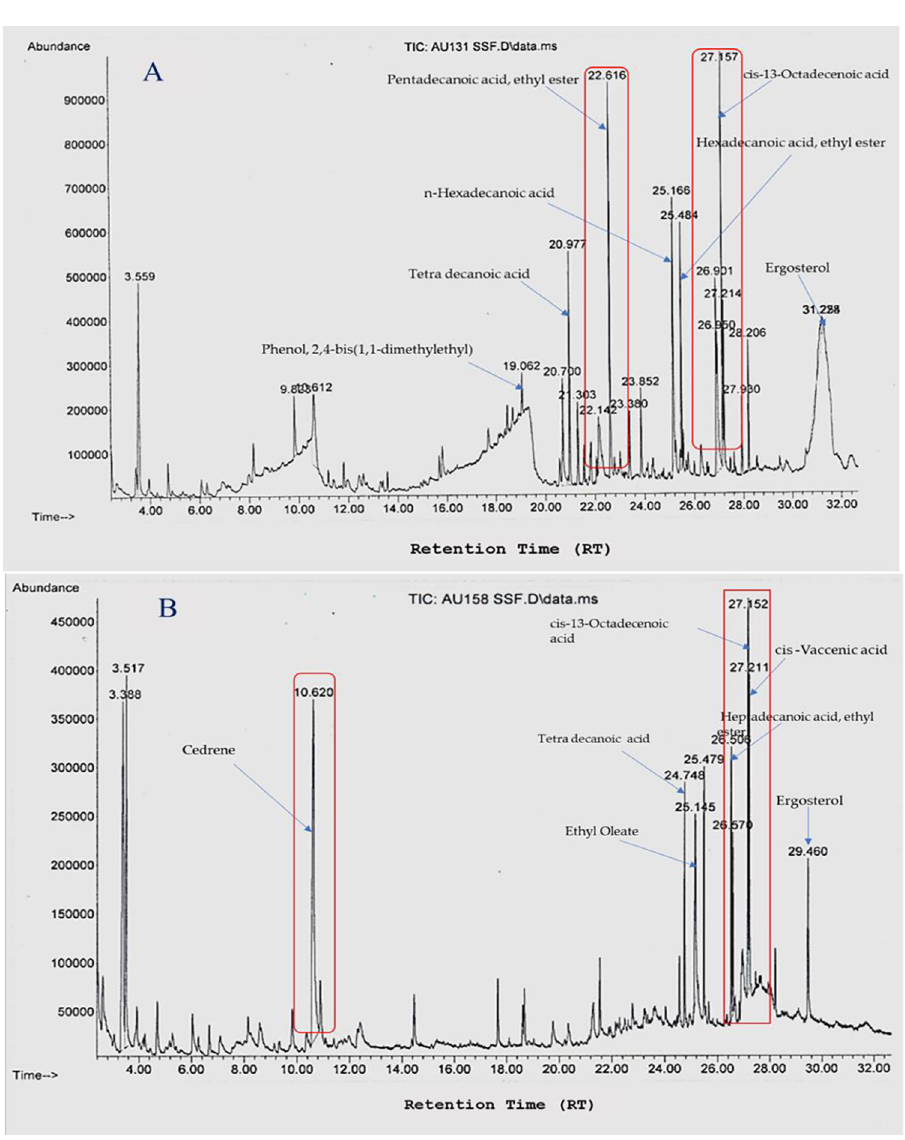
Fig 3. Chromatograms of the volatile organic compounds identified from T . asperellum AU131 ( A ) and T . longibrachiatum AU158 ( B ) crude